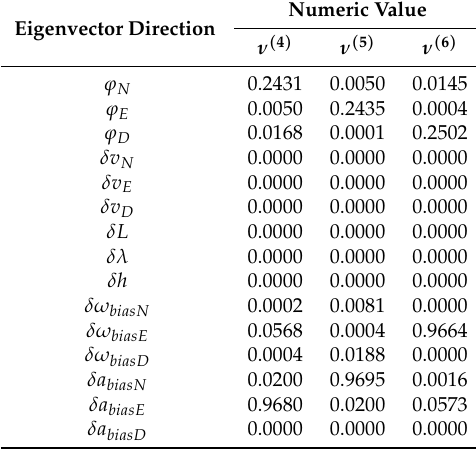
Table 7. Stationary eigenvectors ( t = 60 min) relative to the largest eigenvalues in the repeated experimental